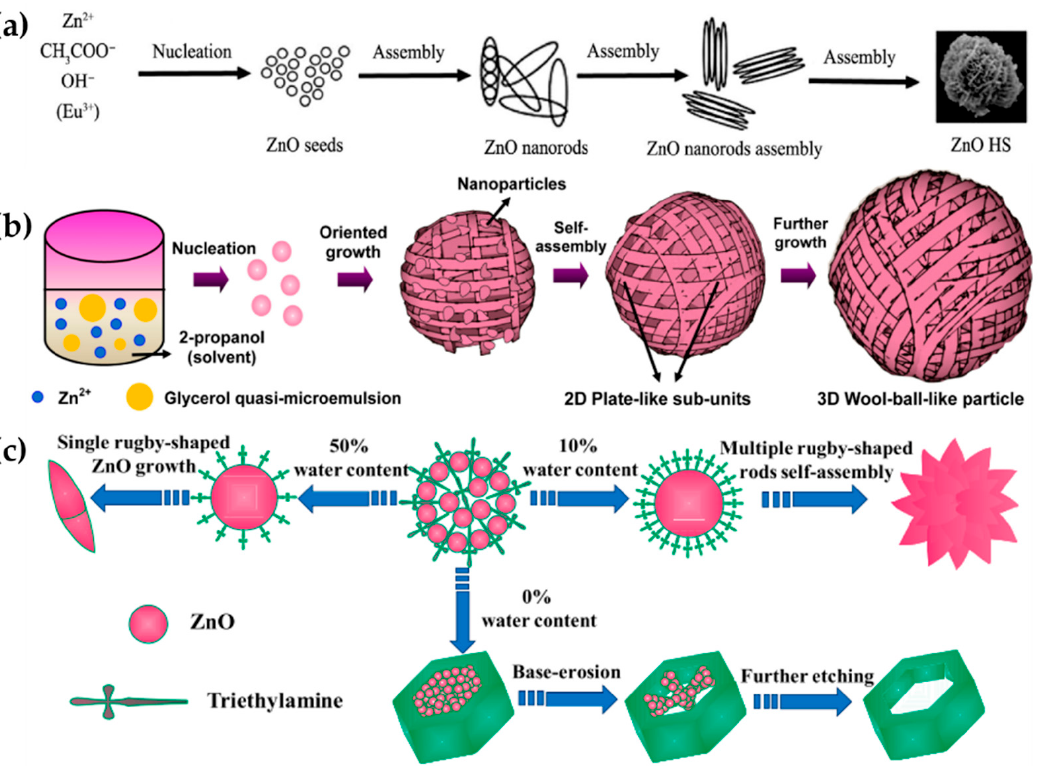
Figure 3. Crystal growth mechanism of ( a ) Nano fl ower-like ZnO. Reprinted with permission from [52]. Copyright 2019 Elsevier. ( b ) 3D wool ball-like ZnO. Reprinted with permission from [56]. Copyright 2018 Elsevier. ( c ) Hexagonal ring-like ZnO. Reprinted with permission from [53]. Copyright 19 Elsevier.